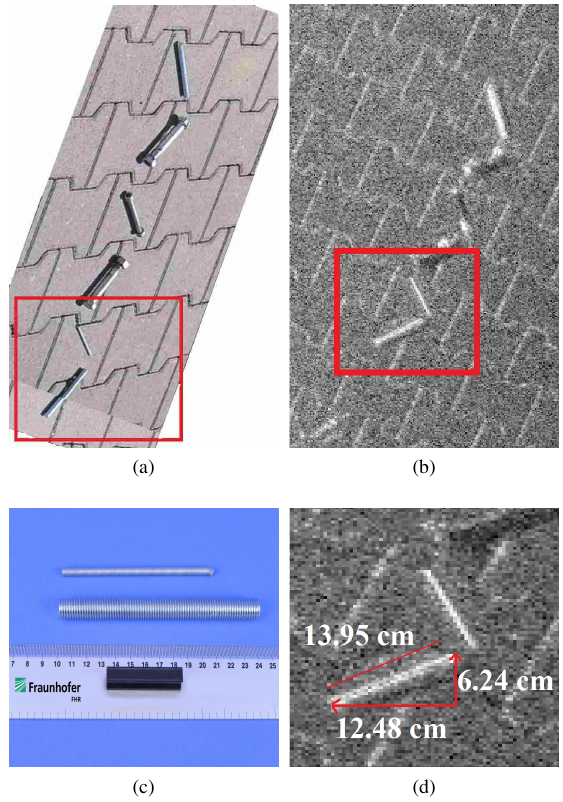
Figure 7: SAR measurements of metallic objects (screws and threaded rod) on car parking with 5 mm resolution. Zoom from the center of Fig. 4c. (a) Photograph of the scene. (b) SAR image of these objects on paving stones. (c) Validation of the object’s length. (d) Zoom ( ∼ 30 cm x 30 cm) of Fig. 7b. Using the defined pixel spacing of 2 mm the length of the object can be determined to 13 . 95